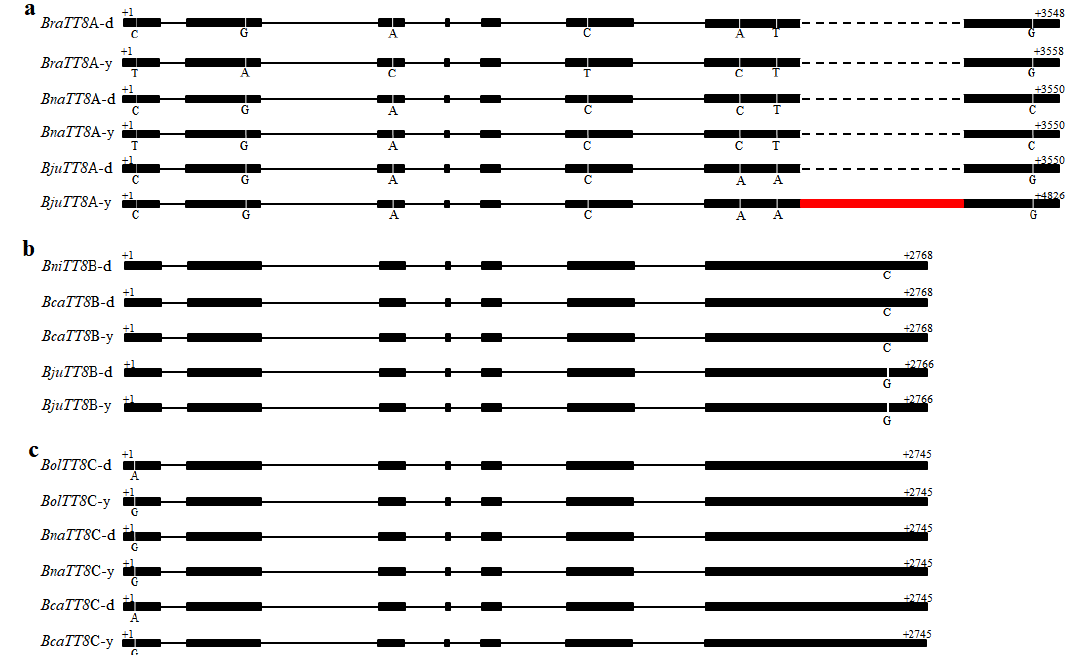
Figure 6. Structural organization of TT8 sequences from Brassica species. ( a ) Structure of TT8 sequences from B . rapa , B . napus , and B . juncea ; ( b ) Structure of TT8 sequences from B . nigra , B . carinata, and B . juncea ; ( c ) Structure of TT8 sequences from B . oleracea , B . napus, and B . carinata . The black rectangles represent the exons. The red rectangle represents the insertion in BjuTT8 A-y. The lowercase letter y and d at the end of gene name represent the yellow- and dark-seeded seed coat color, respectively. Details of the sequence and structural organization of TT8 are shown in Supplementary File S1.